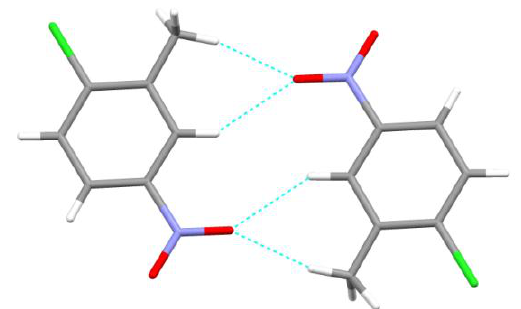
Figure 4. Inversion related dimers formed from C–H…O hydrogen bonds [17].